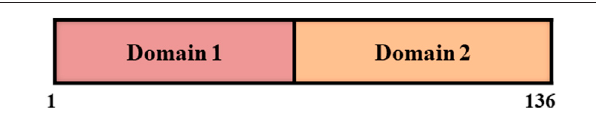
FIGURE 3 | Domain structure of nattokinase consisting of a single polypeptide